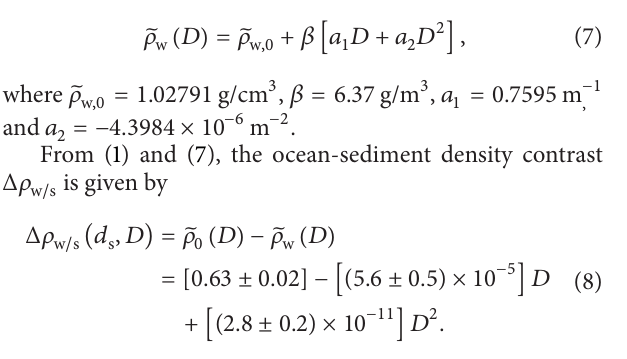
Figure 9: Values of the upper sediment density [in g/cm 3 ] at 457 DSDP drill sites used for the analysis of the lateral density change with respect to the ocean